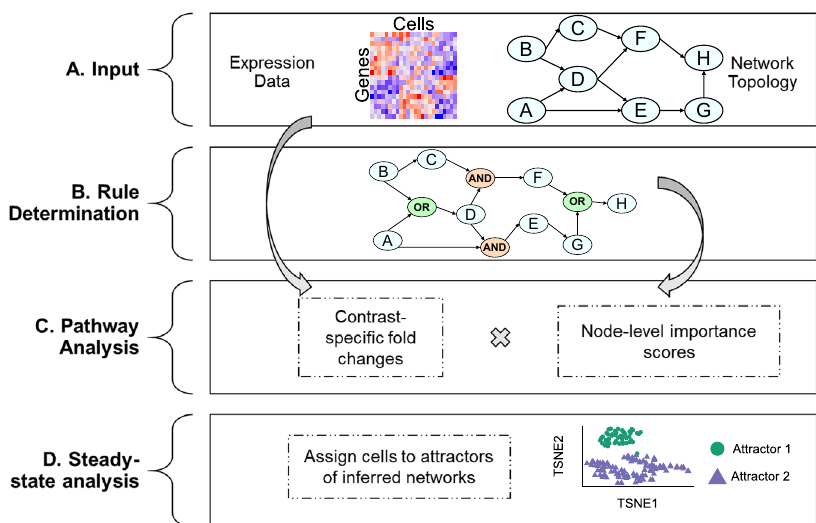
Fig. 2 scBONITA pipeline to infer Boolean rules and perform pathway analysis using single-cell expression measurements. A Input : a binarized single-cell RNA-seq dataset as a text fi le, and a prior knowledge network (PKN) describing the activating or inhibitory relationships between genes. B Rule determination : inference of logic rules that describe the regulatory relationships between nodes in the PKN by a global search followed by node-level rule re fi nement. C Pathway analysis : scBONITA calculates a gene importance score calculated by simulating network perturbations with inferred rules and combines these scores with fold-changes from scRNA-seq to identify differentially regulated pathways in a speci fi ed contrast. D Steady-state analysis : scBONITA simulates networks using learned rules to identify steady states which correspond to observed cellular